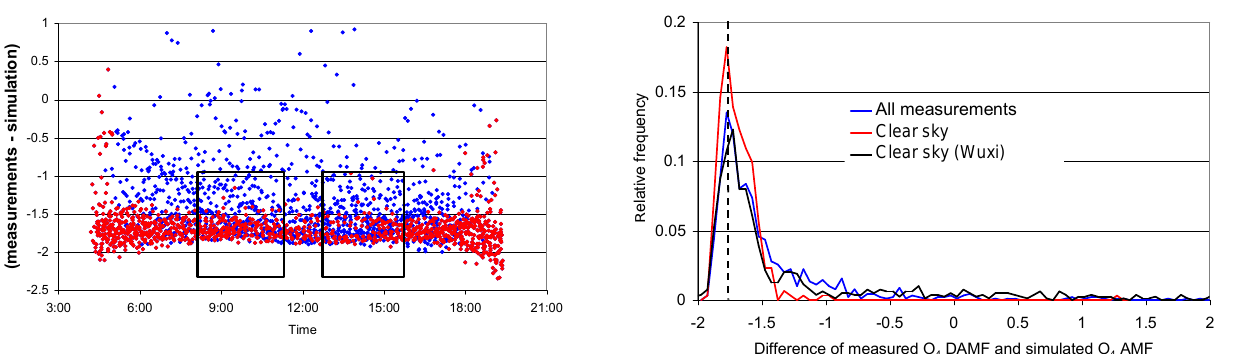
Figure 8. Frequency distribution (for bins of 0.05) of the normalised O 4 DAMF for SZA between 30 and 50 ◦ . The blue and red curves represent observations at Cabauw for all sky conditions (896 mea- surements) and clear-sky conditions (302 measurements) respec- tively. For both selections the frequency maximum is found for − 1 . 78. The black curve represents the frequency distribution for clear-sky observations at Wuxi (790